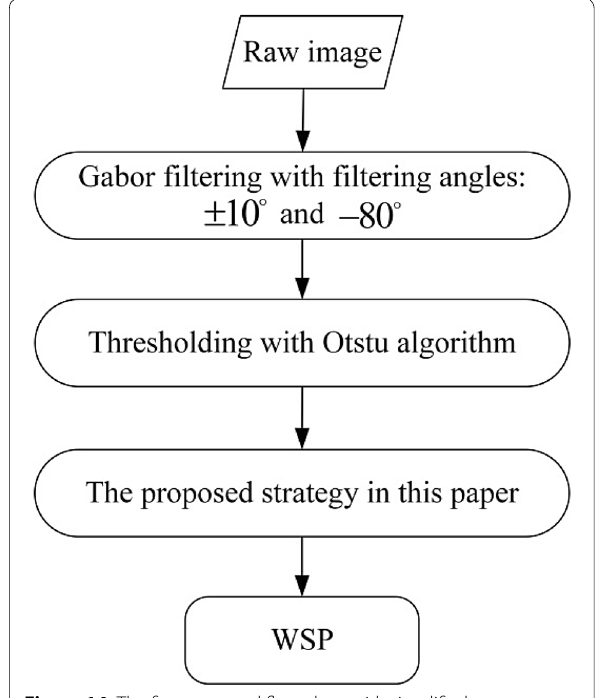
Figure 14 The first proposed flow chart with simplified preprocessing for WSPE